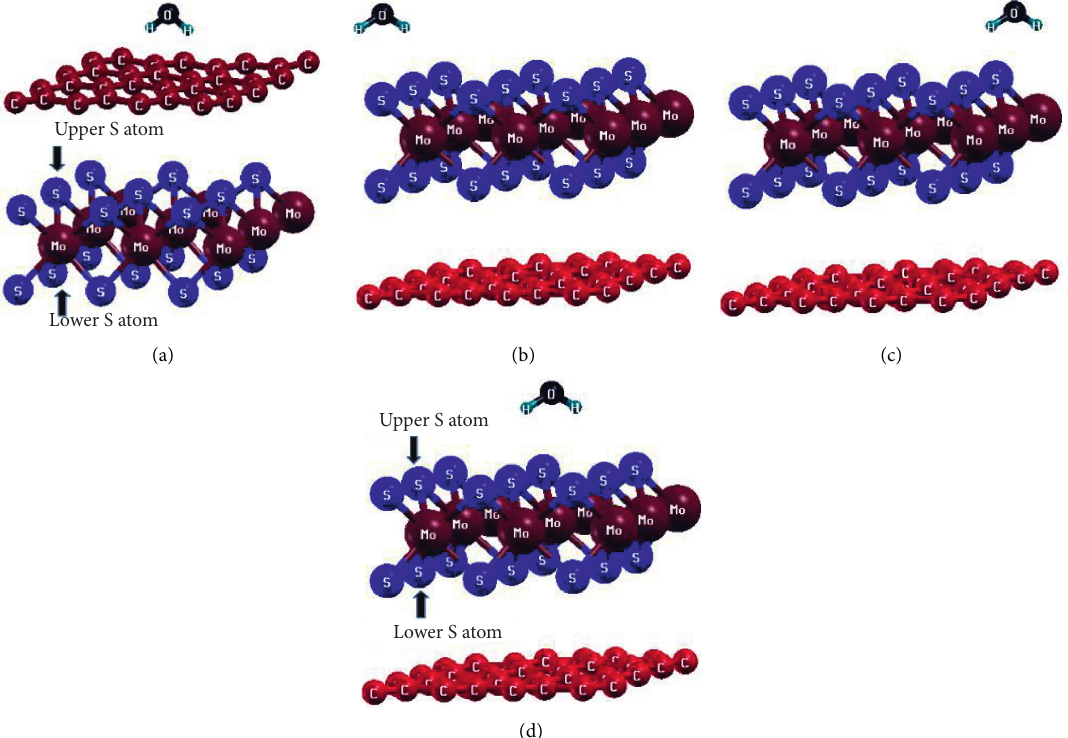
2 HS. (b) adsorbed water molecule is